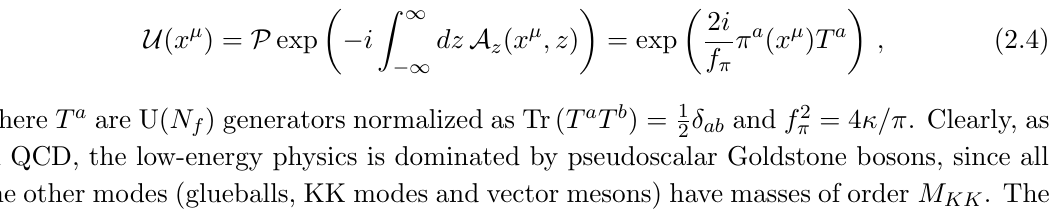
circle and extend in the transverse radial 4